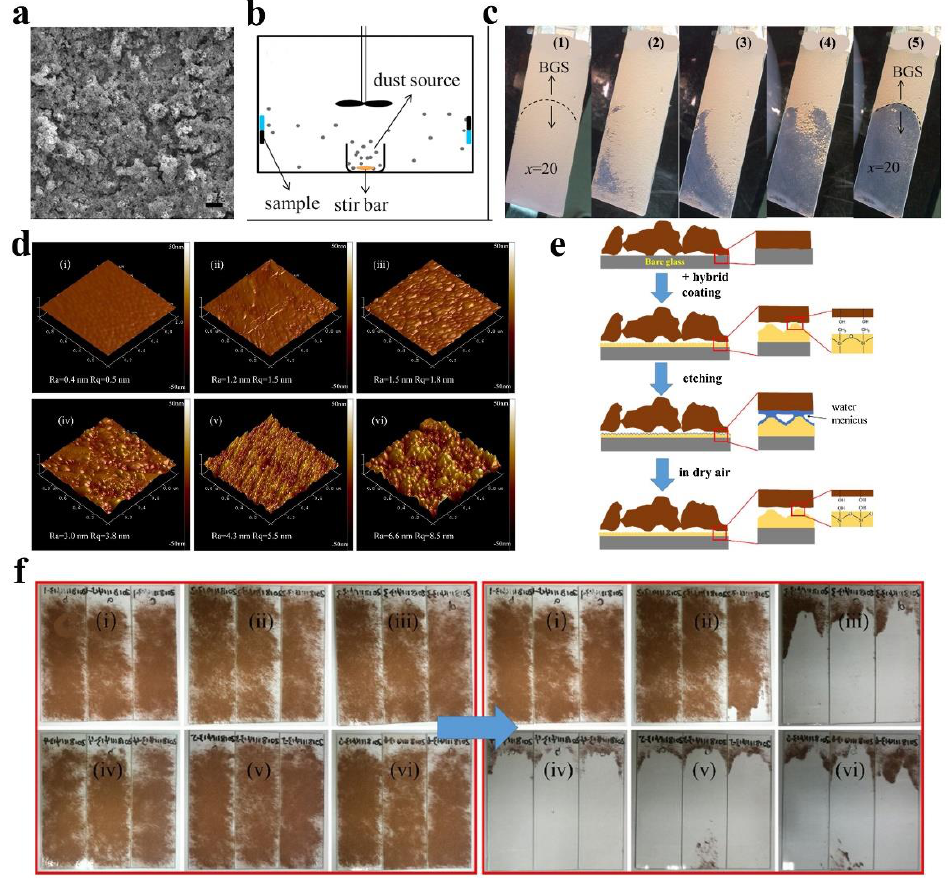
Figure 7. ( a ) SEM image of silicon-based hydrophobic coating. ( b ) Anti-dust properties test device. ( c ) Dust particles are blown away from the coating surface by the wind, reproduced with permission from Ref. [47]. ( d ) Morphology diagram and ( e ) anti-dust mechanism of transparent hydrophobic coating. ( f ) Anti-dust performance of hydrophobic coating under gravity, reproduced with permission from Ref. [75].